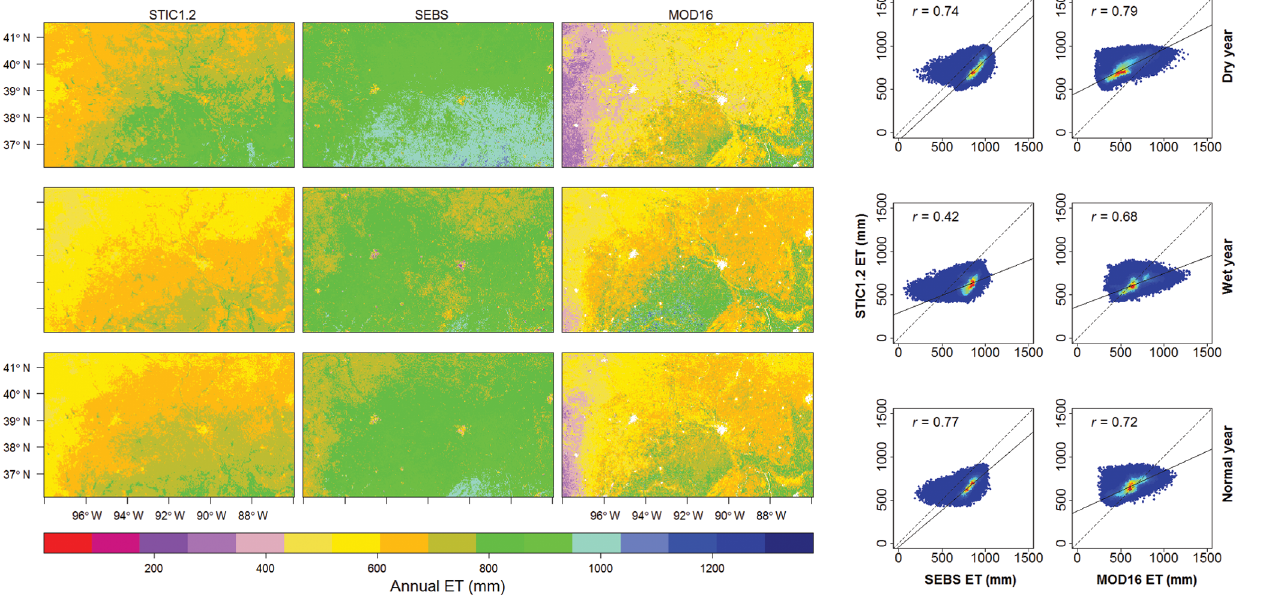
Figure 10. Annual ET (mm) maps for the dry, wet, and normal years derived from STIC1.2, SEBS, and MOD16 for Midwest1 (MW1) bounding box covering US-Kon, US-KFS, US-ARM, US-Ne1, and US-MMS flux sites (Fig. 1). Scatter plots between annual ET estimates from STIC1.2 vs. SEBS and MOD16 are shown on the